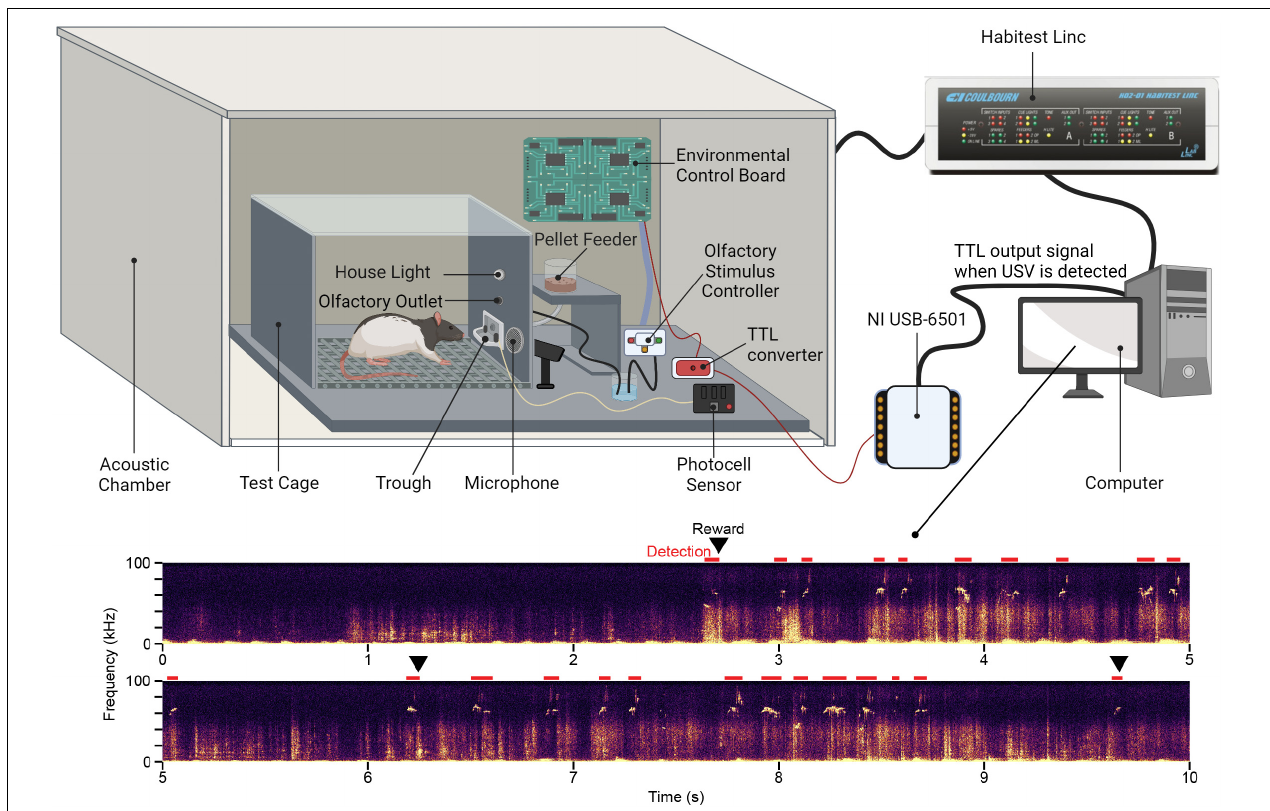
FIGURE 1 | Schematic of the equipment used for semi-automated ultrasonic vocalization training Figure created with